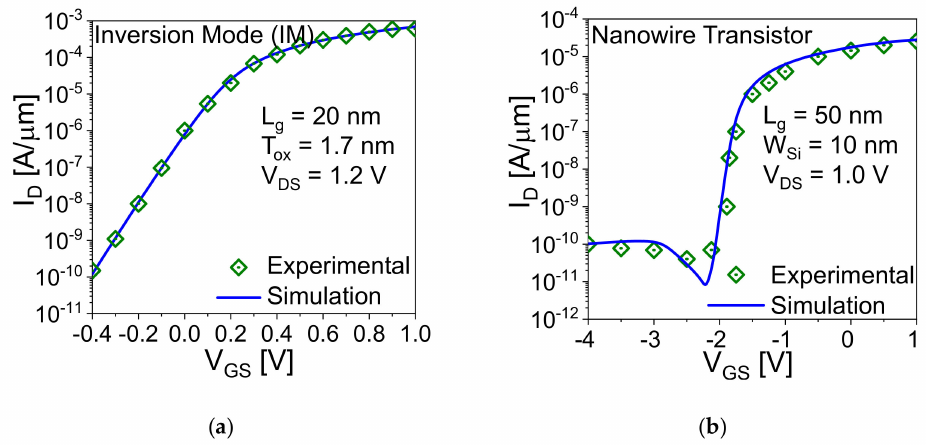
Figure 2. Comparison of simulated transfer characteristic with experimental ( a ) double-gate inversion mode [29] and ( b ) nanowire transistor